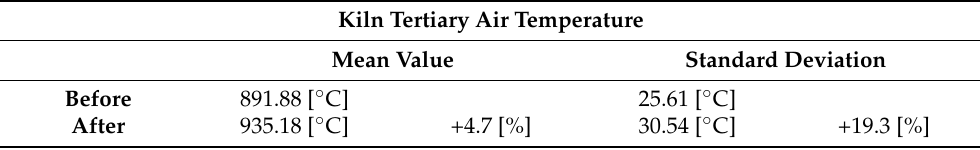
Figure 36. Rotary kiln APC system: KPI evaluation (monthly energy-saving and cumulative energy- saving after APC system activation). Table 11. Grate cooler APC system: KPI evaluation (kiln tertiary air temperature).